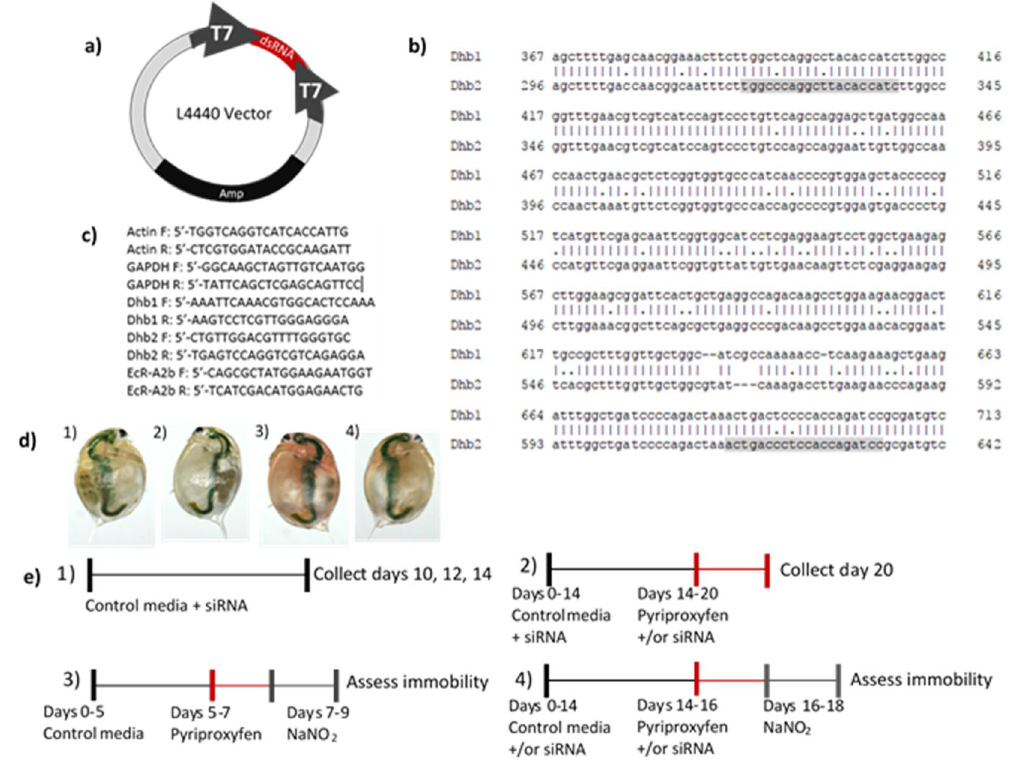
Figure 6. Methodological details. ( a ) Bacteria were transformed with the L4440 vector with or without the dsRNA target sequence. Location of the target sequence is indicated in red between two T7 promoters. The black region designates the ampicillin resistance gene. ( b ) The nucleotide sequence cloned into the L4440 vector for the production of dsRNA. Primers designed to clone the target sequence of Dhb2 are shaded in gray. These primers also amplified the paralogous sequence for Dhb1. ( c ) Primer sequences used for quantitative RT-PCR. ( d ) Coloration of daphnids reared in: 1) control media and fed bacteria containing empty L4440 vector, 2) control media and fed bacteria containing siRNA-containing L4440 vector, 3) media containing 6.0 nM pyriproxyfen and fed bacteria with empty L4440 vector, 4) media containing 6.0 nM pyriproxyfen and fed bacteria with siRNA-containing L4440 vector. ( e ) Treatment regimens used: 1) days of feeding siRNA required to knockdown targeted gene, 2) modulation of hemoglobin levels by exposure to pyriproxyfen and feeding siRNA, 3) sodium nitrite concentration-response assessment, and 4) toxicity of nitrite with modulated hemoglobin